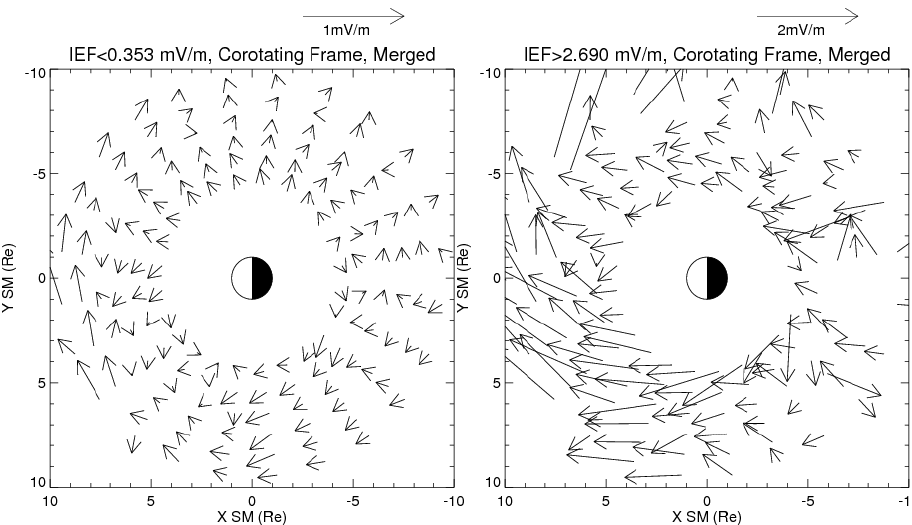
Fig. 2. Average electric field patterns in the corotating frame derived from the Cluster database. The length corresponds to the magnitude of the electric field with a scale shown in the upper right part of each panel. The direction is rotated 90 degrees clockwise, which is the same as the direction of convection. The left and right panels correspond to the patterns for IEF < 0.353mV/m and 2.690 < IEF mV/m, respectively.